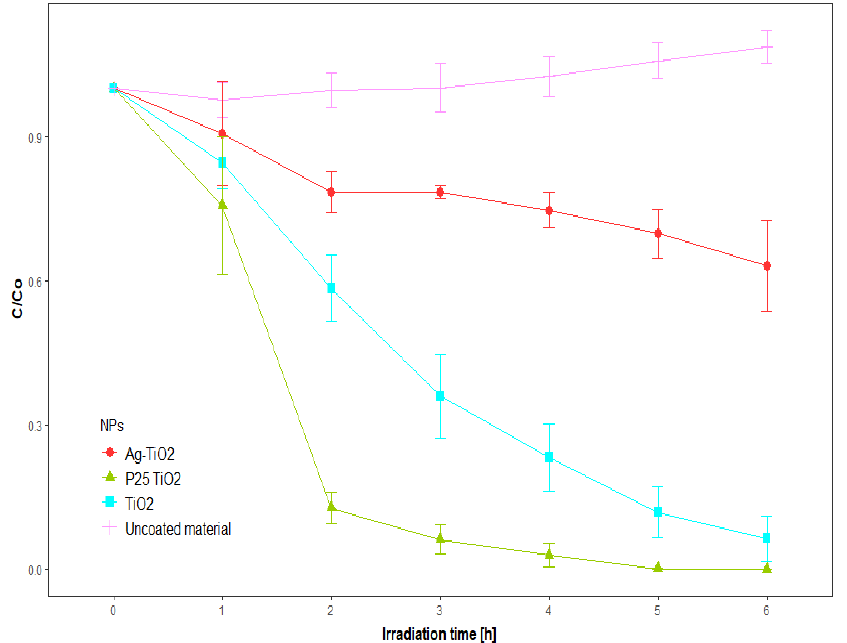
Figure 3. Degradation of the MB solution by uncoated material, Ag-TiO 2 , TiO 2 and P25 TiO 2 supported on HDPE plates (n=3).